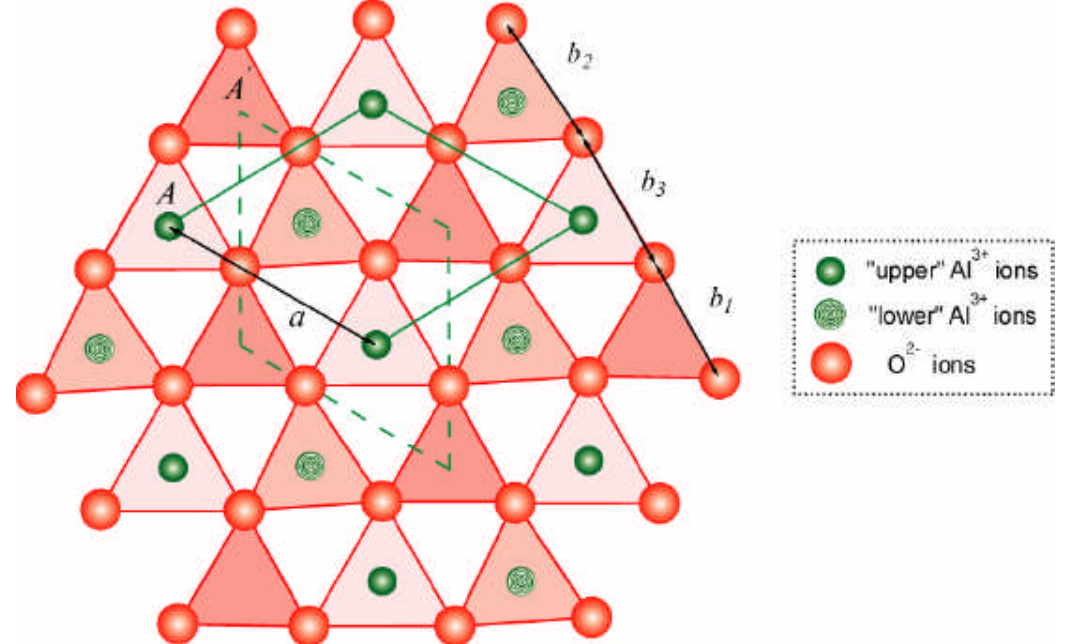
Figure 1 . Top view of the oxygen plane of the corundum (0001) substrate, as optimized in [13], and two neighboring aluminium planes positioned above and below the oxygen plane (green circles with different internal patterns). In these planes, Al 3+ ions form a hexagonal network with a rhombic unit - cell, whereas O 2 ions form a more complicated regular structure containing equilateral triangles of three different sizes. Each may be distinguished by the shade of red color used, the larger the triangle the lighter the shading used. Intermediate versatile triangles are shown in